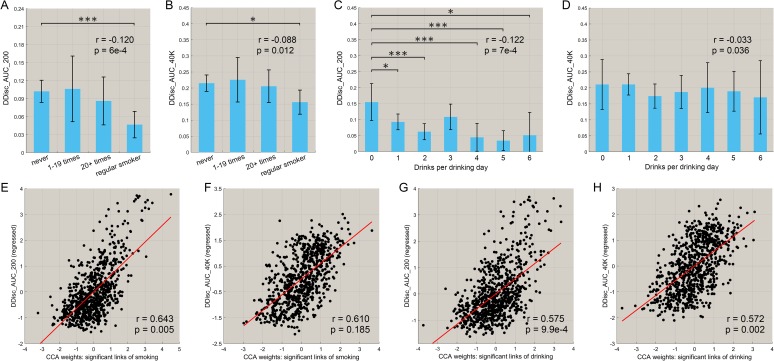
Correlation between the strength of functional connectivity and temporal discounting behavior (impulsivity).(A, B) The delay discounting score for different subgroups with different frequencies of smoking. A low score reflects choices for immediate reward as compared with longer term reward. The delay discounting scores are significantly lower in the regular smoking group compared with the non-smoker group. The correlations between the delay discounting scores and the amount of substance use behavior are shown in the top right corner (with the same for the other figures). The error bars show the standard error of the mean (SEM) in this and other Figures. (C, D) The delay discounting scores for subgroups with different amounts of drinking. The delay discounting scores are significantly lower in the high drinking group compared with the low drinking group. (E, F) The canonical correlation between the delay discounting score and the strength of the significantly different links in the smoking dataset. The scatter plot shows the delay discounting score versus the functional connectivity weights, with one point per participant. The high correlation shown here indicates a significant co-variation between the FCs and the delay discounting score. (G, H) The same for the drinking group. (* indicates p<0.05, **p<0.005 and ***p<0.0005).